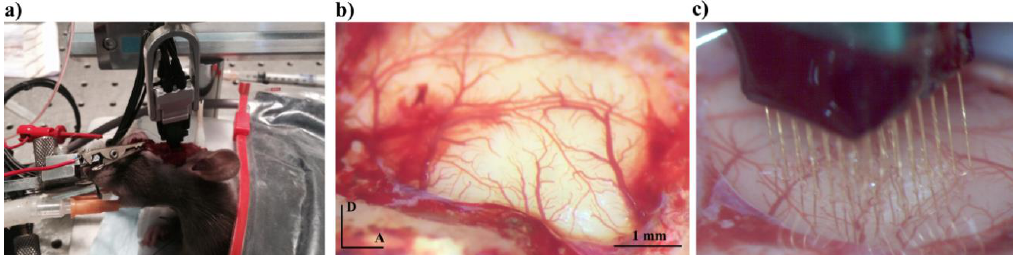
Figure 1. In vivo image of the mapping of the primary auditory cortex, A1 ( a ), delimited by local blood vessels ( b ) and the implanted 8 × 8 microelectrodes array ( c ). “A” stands for anterior direction, and “D” for dorsal direction.